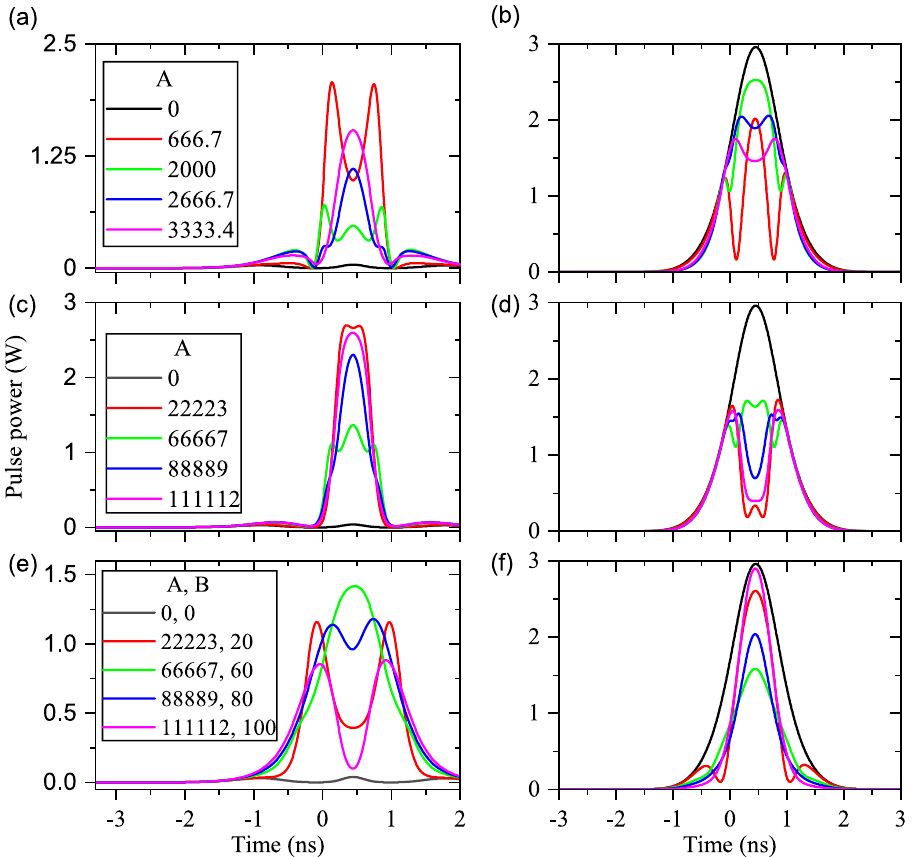
Figure 3. Effects of different types of linear waveguide (L = 60 mm) inhomogeneities for the pulsed-SHG process. ( a ) and ( b ) are the fundamental and SH pulse shapes under the effects of linear inmomogeneity ( �β = A ( x − 0.03 ) ), respectively. ( c ) and ( d ) display the fundamental and SH pulse shapes, respectively, when �β changes quadratically ( �β = A ( x − 0.03 ) 2 ). ( e ) and ( f ) represent the fundamental and SH pulse shapes, 2 + B respectively, when �β changes upside-down quadratically ( �β = − A ( x − 0.03 )